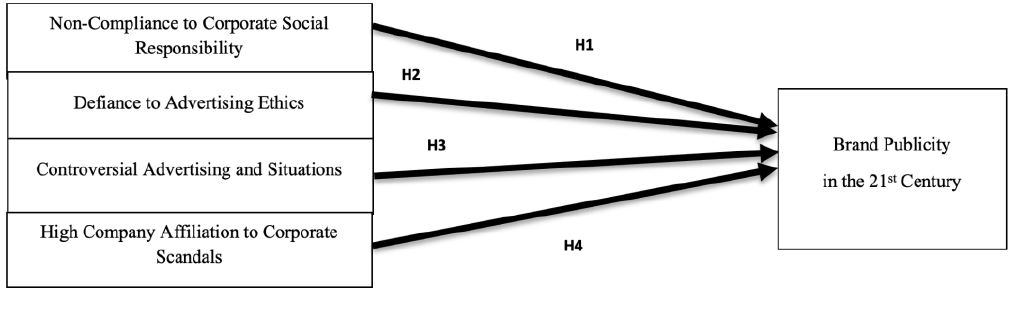
Figure 1: Conceptual Framework/Model of the